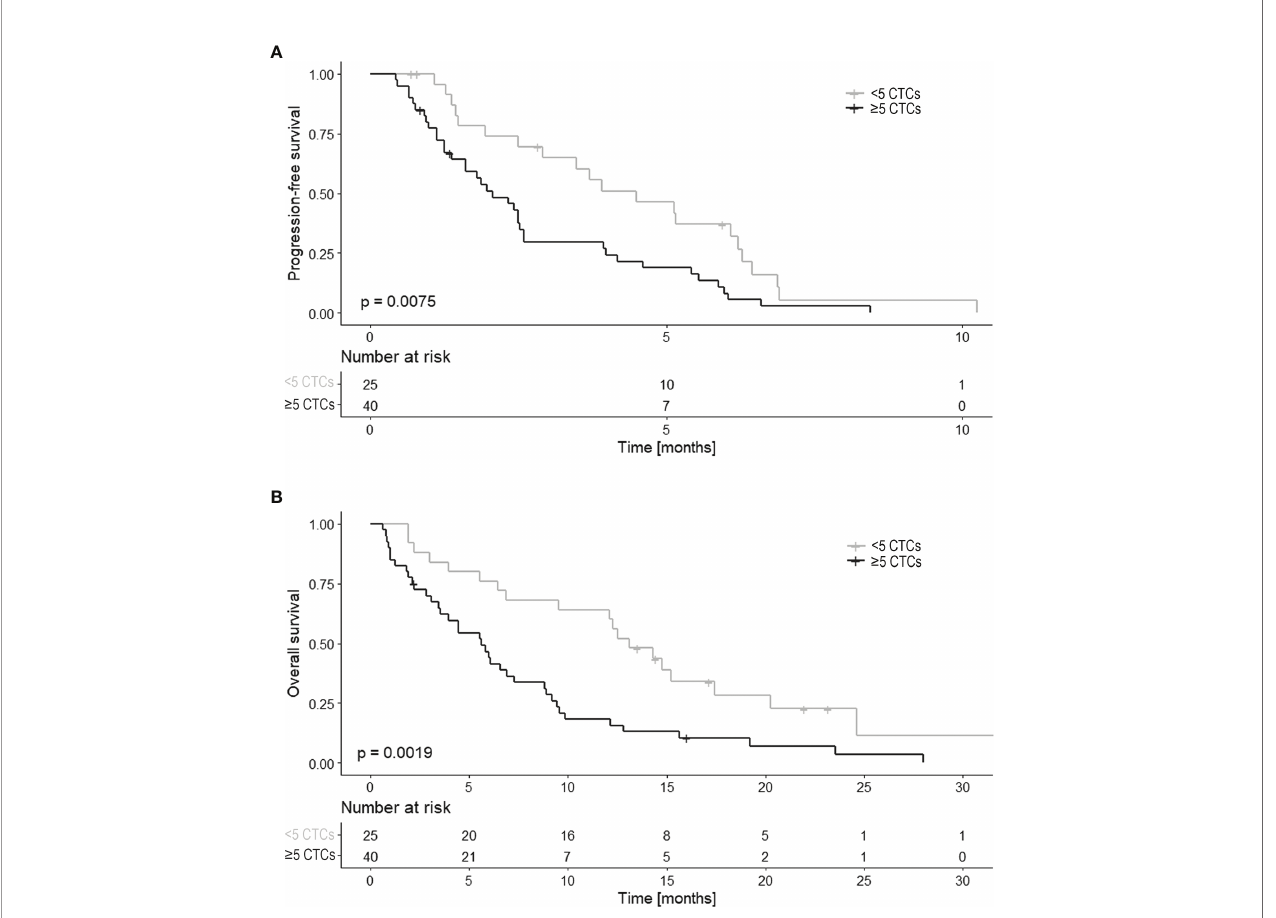
FIGURE 2 | PFS and OS in relation to the CTC count (n=65). Kaplan Meier curves of (A) progression-free survival (PFS) and (B) overall survival (OS) in relation to CTC count at baseline. CTC counts are divided into two categories of < 5 CTCs and ≥ 5